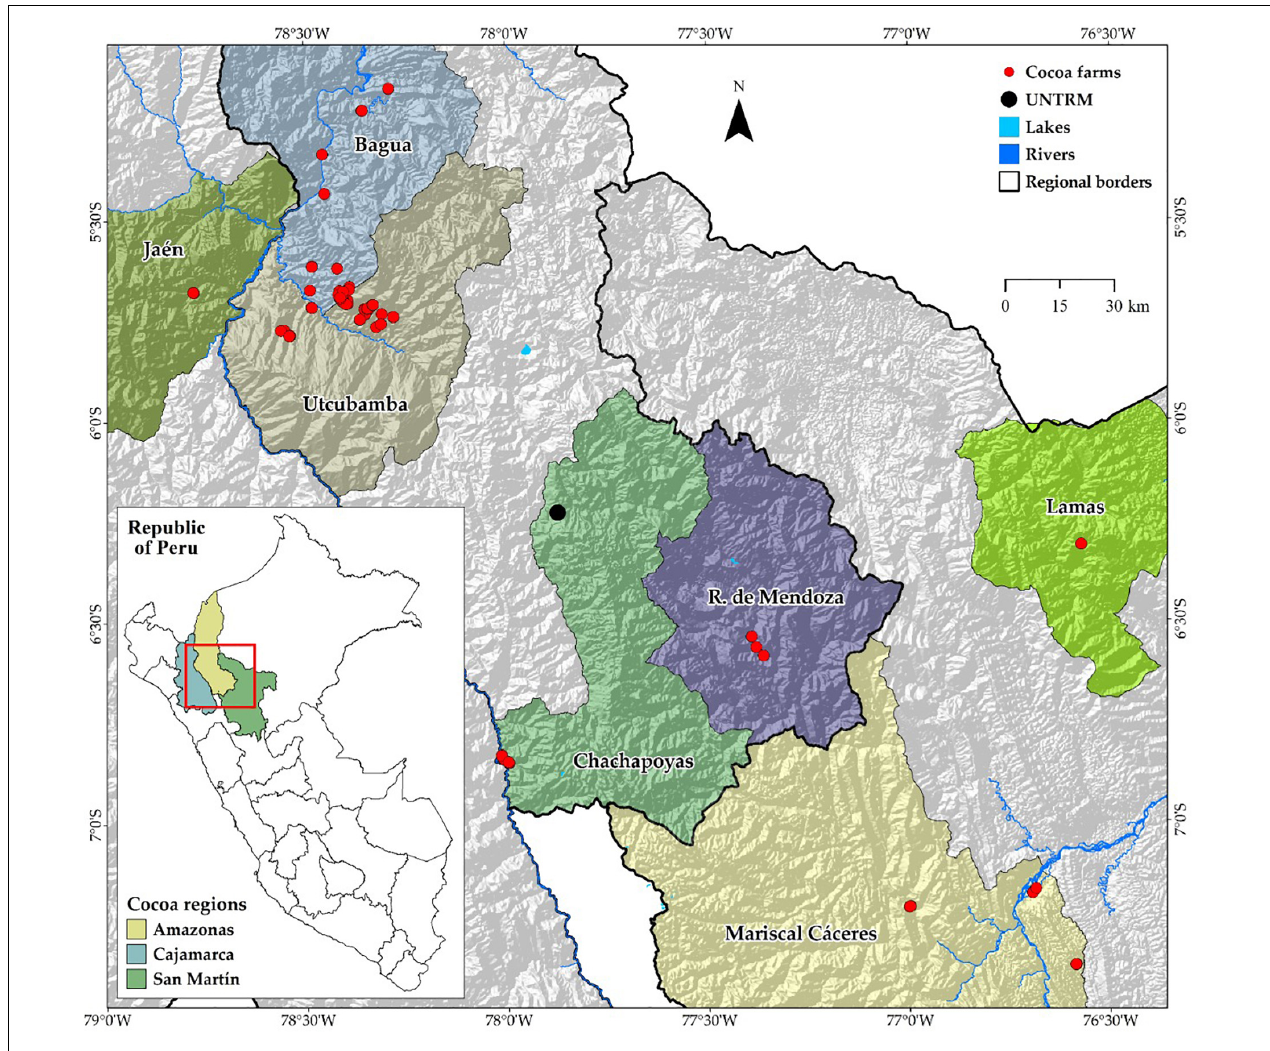
FIGURE 1 | Distribution map of FFNC ecotypes in the northeastern region of